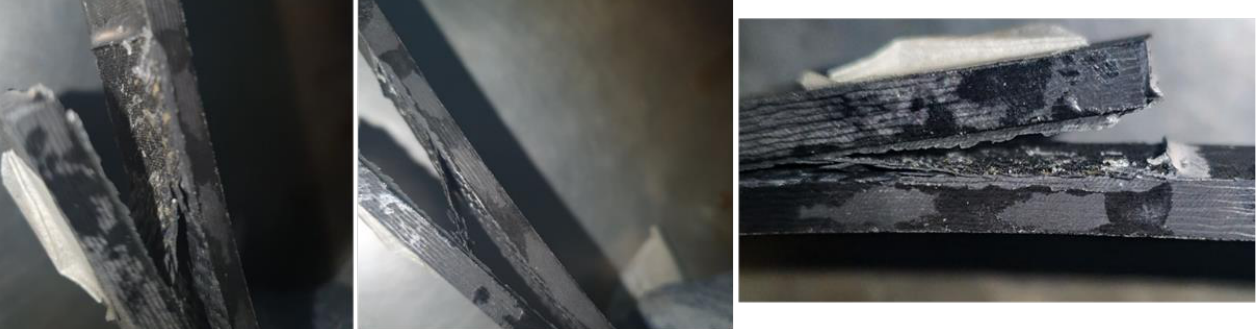
Figure 27. Images from fractured surfaces of RTM6 lap strap specimen.